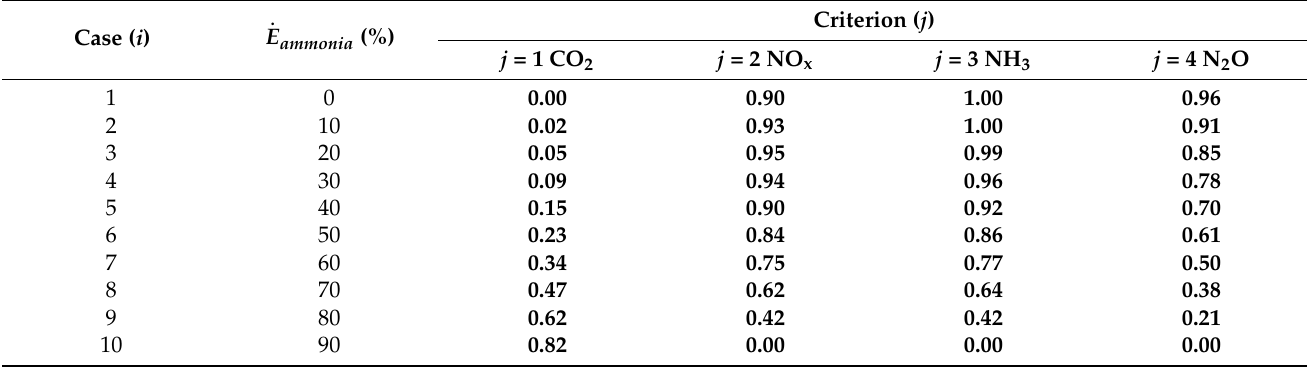
Table 3. Normalized decision matrix.